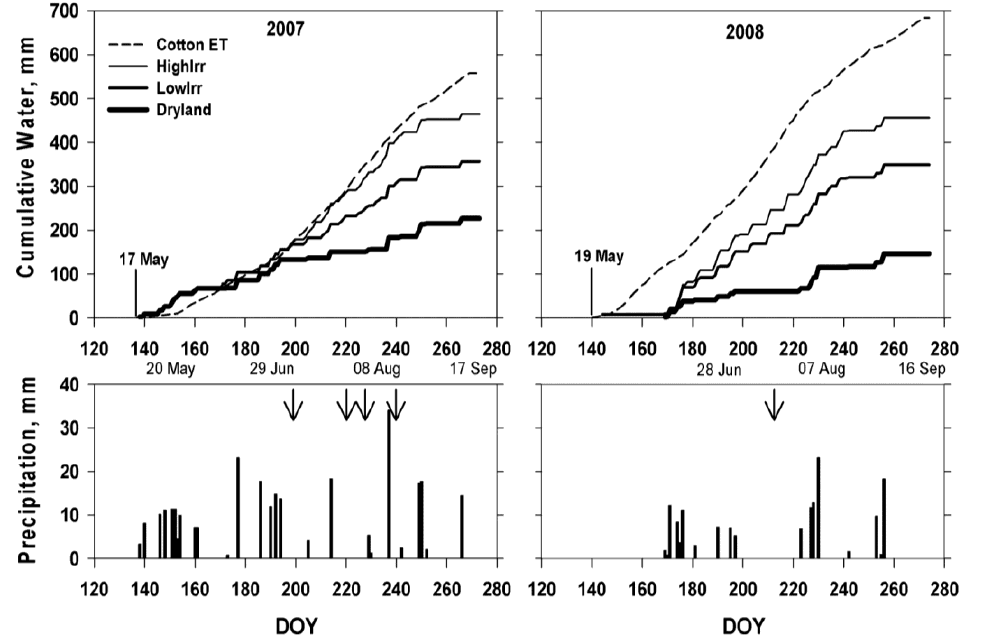
Figure 1. ( Top ) Cumulative crop evapotranspiration (ET), rainfall and applied total water (irrigation plus rainfall) for the high irrigated (HighIrr), low irrigated (LowIrr) and non-irrigated (dryland) treatments plotted vs. the day of year (DOY); ( Bottom ) the amount and timing of daily precipitation events. The results are presented for the 2007 and 2008 growing seasons from planting (vertical line with date) to crop maturity. Arrows indicate the dates on which airborne remote sensing imagery was